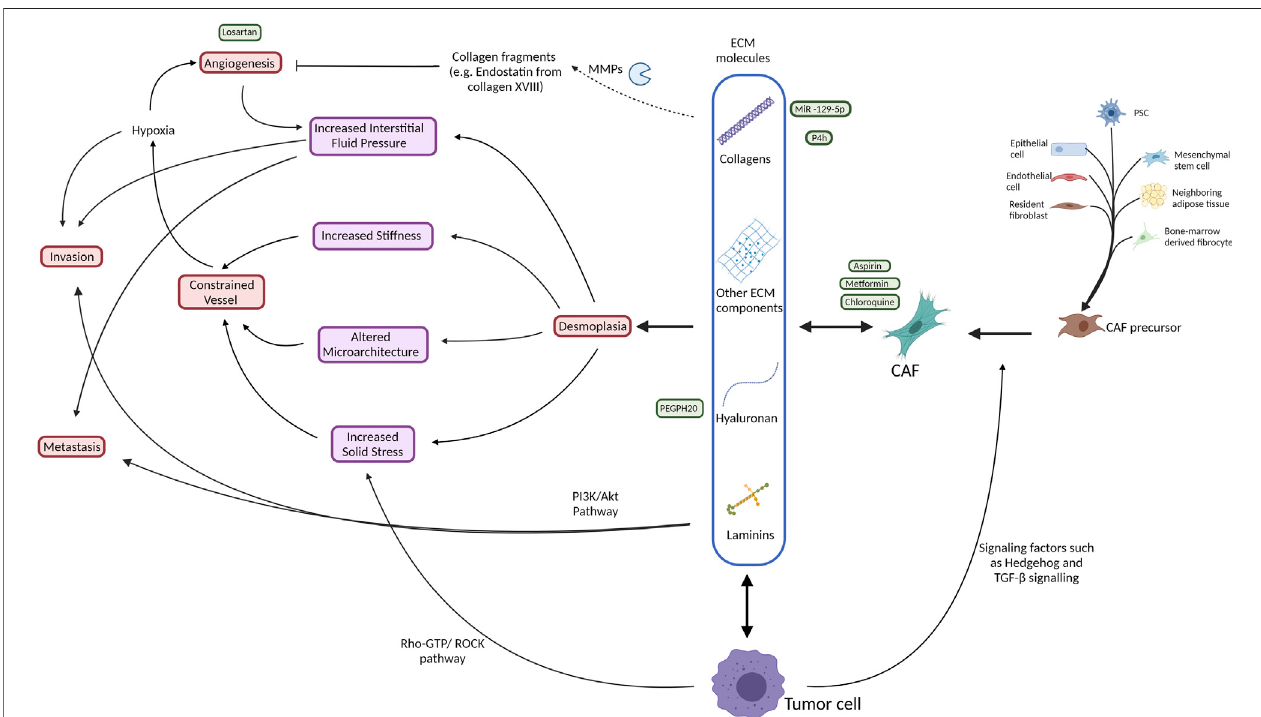
FIGURE2| SchematicillustrationoftheinteractivenetworkofthetumorstromawithrespecttoECMproduction(bluebox)anditseffectsonbiomechanical(purple) traits and induction of physiological processes (red) within the tissue. Additionally, indicated are various approaches to therapeutic intervention (green). Broadly, both tumor cells and CAFs, which have several cell types of origin, produce ECM proteins that contribute to desmoplasia, consequently increasing tissue stiffness, pressure and architecture in a manner that constrains vessels, leading to a hypoxic environment. This hypoxic environment promotes angiogenesis and cell invasion. The increased angiogenesis results in an increased interstitial fl uid pressure that acts to promote invasion and metastasis of the tumor cells. The tumor cells themselves also contribute directly by means of their proliferation to increase the solid stress of the tissue that also supports a feedback loop by constraining vessel access to the tissue. Attempted therapeutic interventions include reduction of CAF formation, degradation of ECM collagens and hyaluronan, MMP inhibition and anti-angiongenic treatments. Akt, protein kinase B; CAF, cancer associated fi broblast; COL, collagen; ECM, extracellular matrix; GTP, guanosine triphosphate; HA, hyaluronan; LAMB3, laminin subunit beta-3; MMP, matrix metalloproteinase; PDAC, pancreatic ductal adenocarcinoma; PEGPH20, PEGylated human recombinant PH20 hyaluronidase; PI3K, phosphatidylinositol 3-kinase; PSC, pancreatic stellate cell; ROCK, Rho associated protein kinase; TGF- β , transforming growth factor β ; TME, tumor